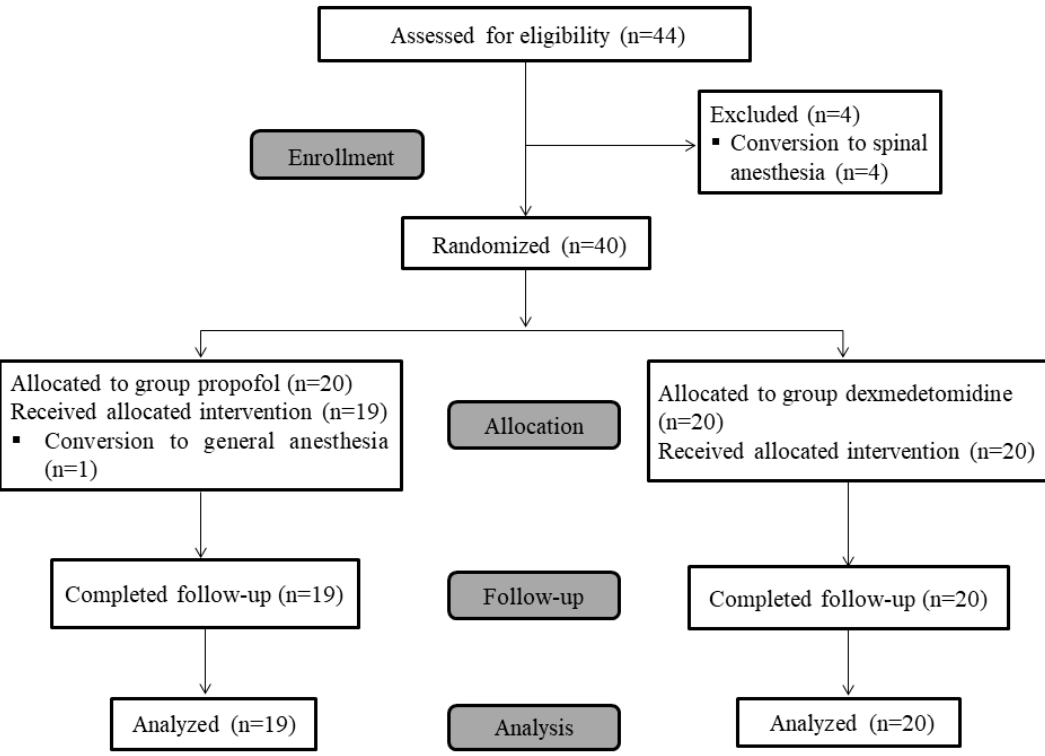
Figure 2. Consolidated Standards of Reporting Trials flow diagram showing patient progress through the study phases.